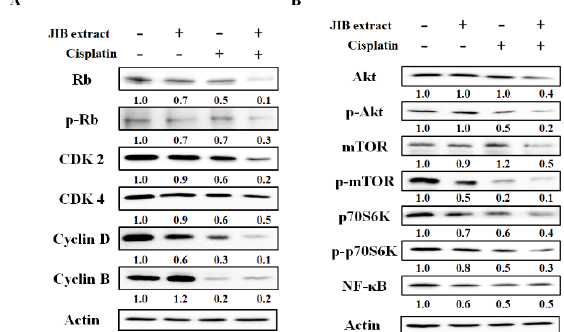
Figure 4. Cell proliferation-related protein expression after treatment with JIB extract plus cisplatin. After treatment, OECM-1 cells were harvested, and total protein was extracted by lysis bu ff er. Total proteins were quantified by BCA assay, and western blotting was performed to detect changes in protein expression due to combination treatment. ( A ) Cell cycle-related protein expression. ( B ) Akt / mTOR signaling protein expression.